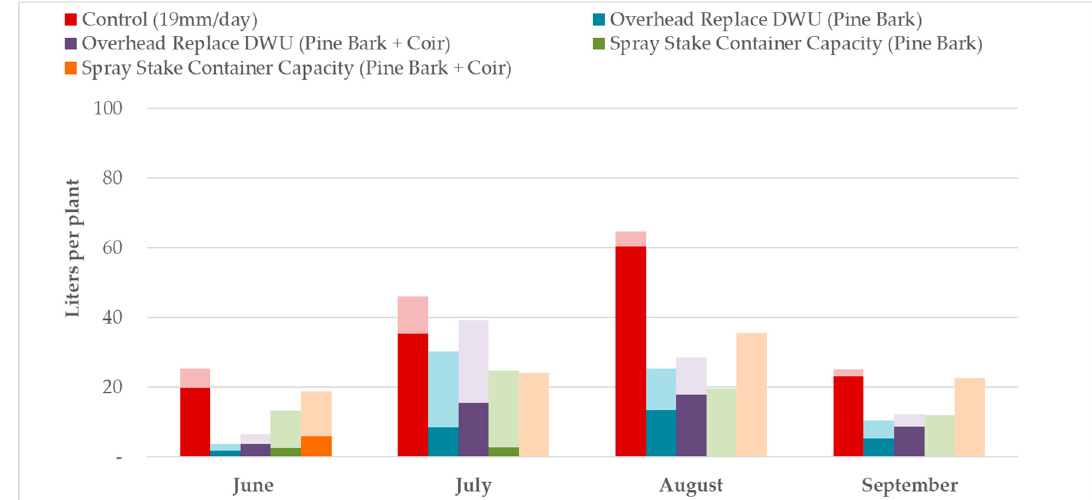
Figure 4. The relative contributions of water scarcity footprint of water dilution requirement (WSF wd ) from runoff and infiltration water on per plant monthly WSF wd of woody plants grown in 10.2 L containers for data collected from June through September 2018, under five irrigation regimens in a model research nursery in Michigan. For each color, darker shade is runoff and lighter shade is infiltration.